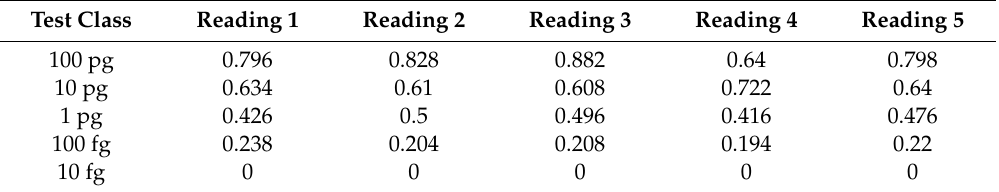
Table 3. Calculated T / C ratio for LFA set #3.